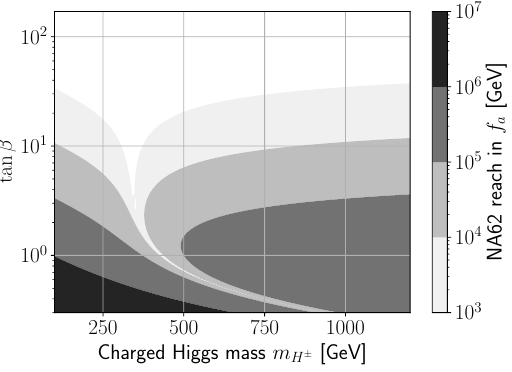
Figure 2 . Expected NA62 reach on f a from K + → π + + a in flavour-universal DFSZ models,